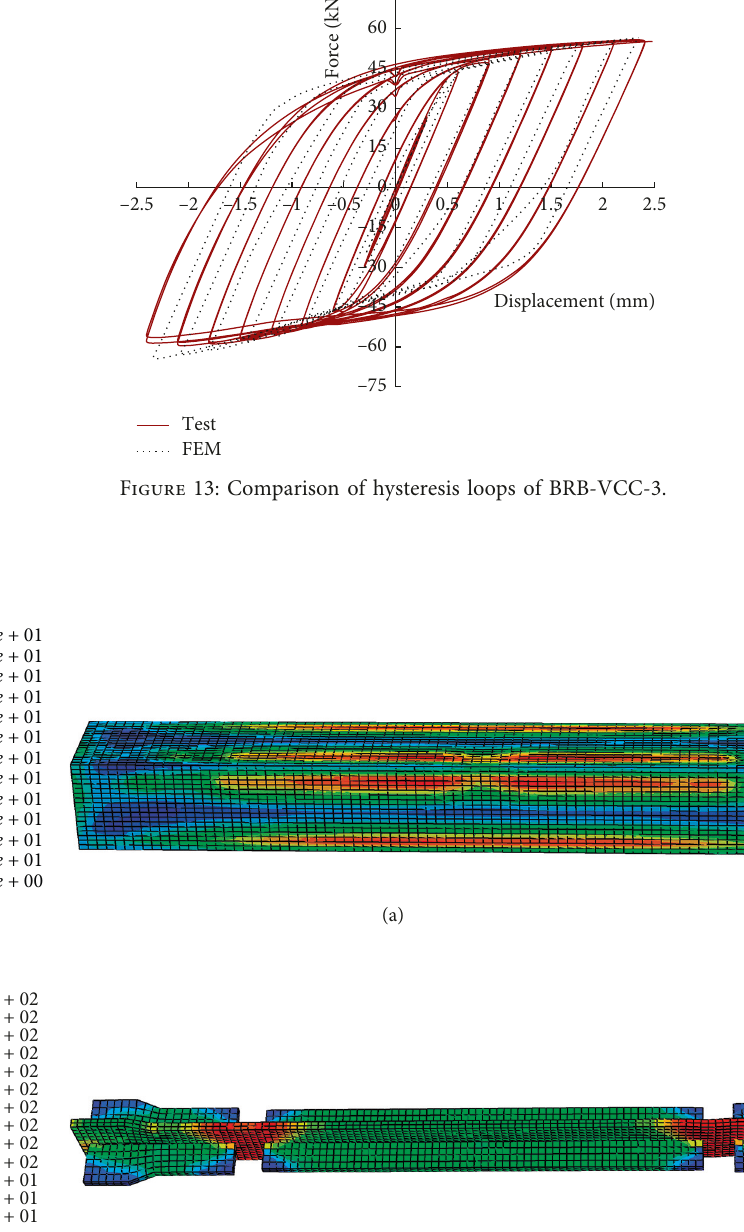
� 95.36N/mm 2 < f max y ). (b) Inner core ( σ max